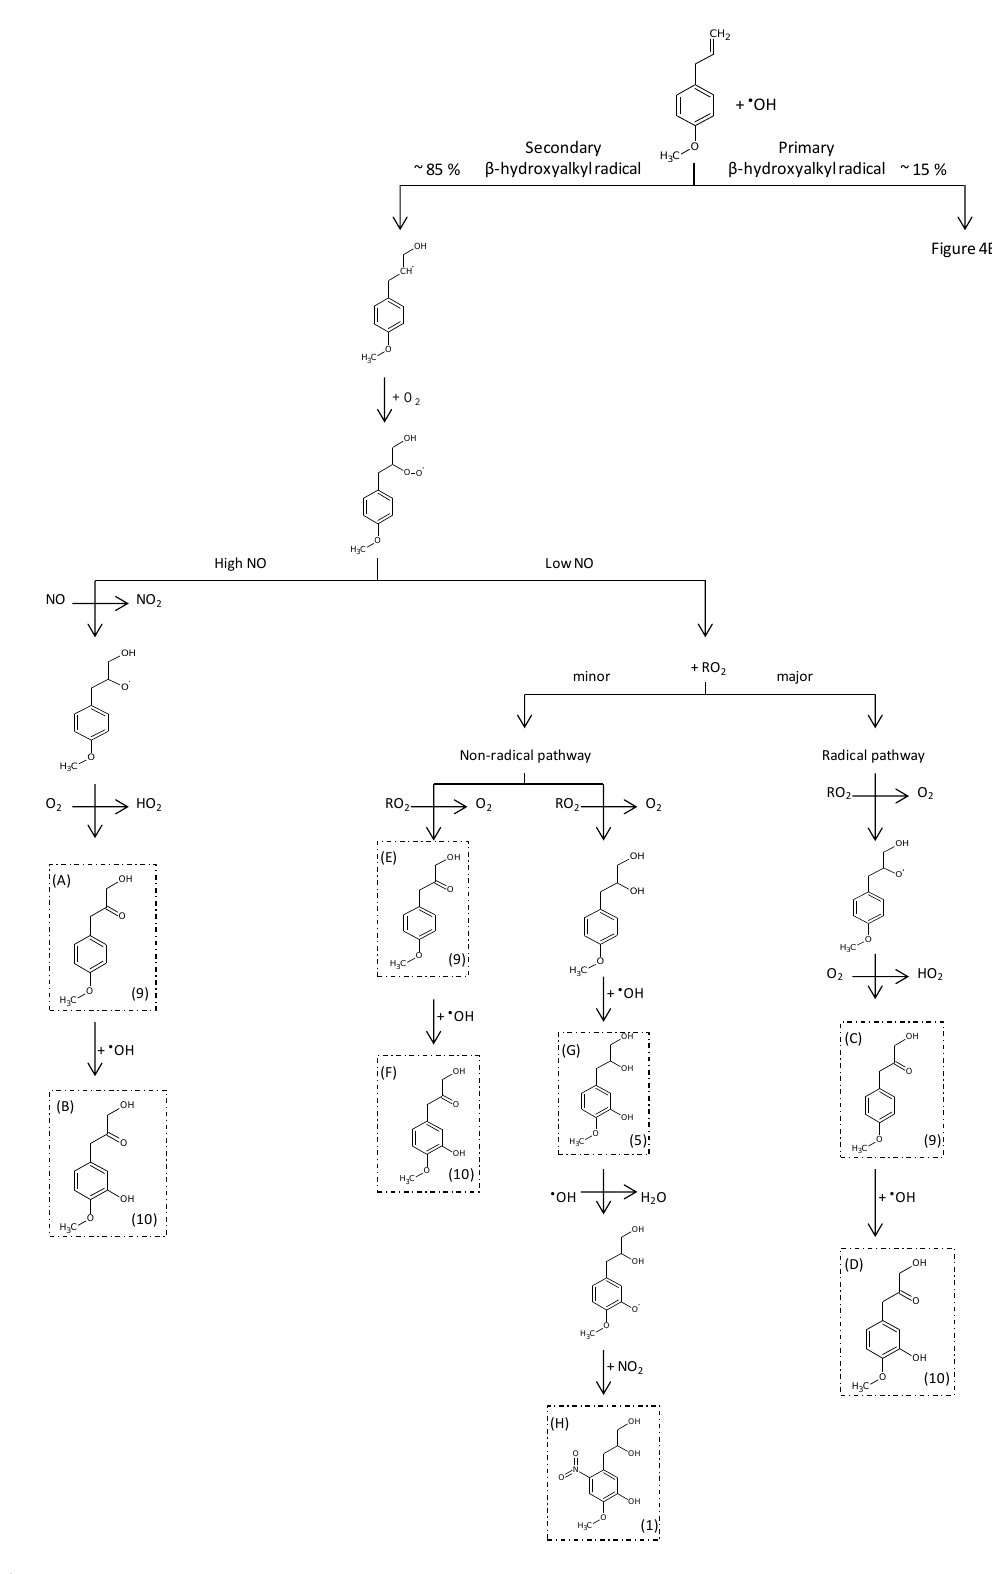
Figure 4. (a) Mechanism of formation for the identified SOA compounds through the secondary β -hydroxyalkyl radical pathway, com- Figure 4a pounds 1, 5, 9 and 10, shown in brackets, refer to Table 2 for compound identification. See text for the explanation of the mechanism, letters refer to the explanation in the text. Boxes highlight identified SOA